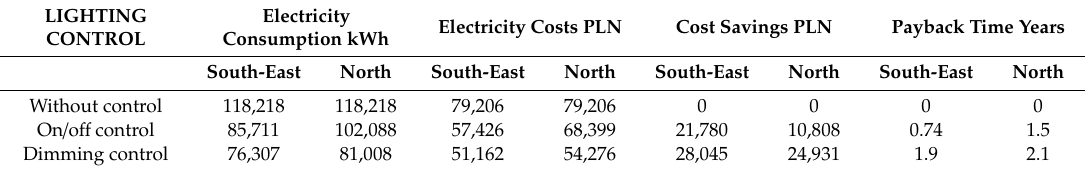
Table 2. Electricity consumption and costs as well as cost savings and payback